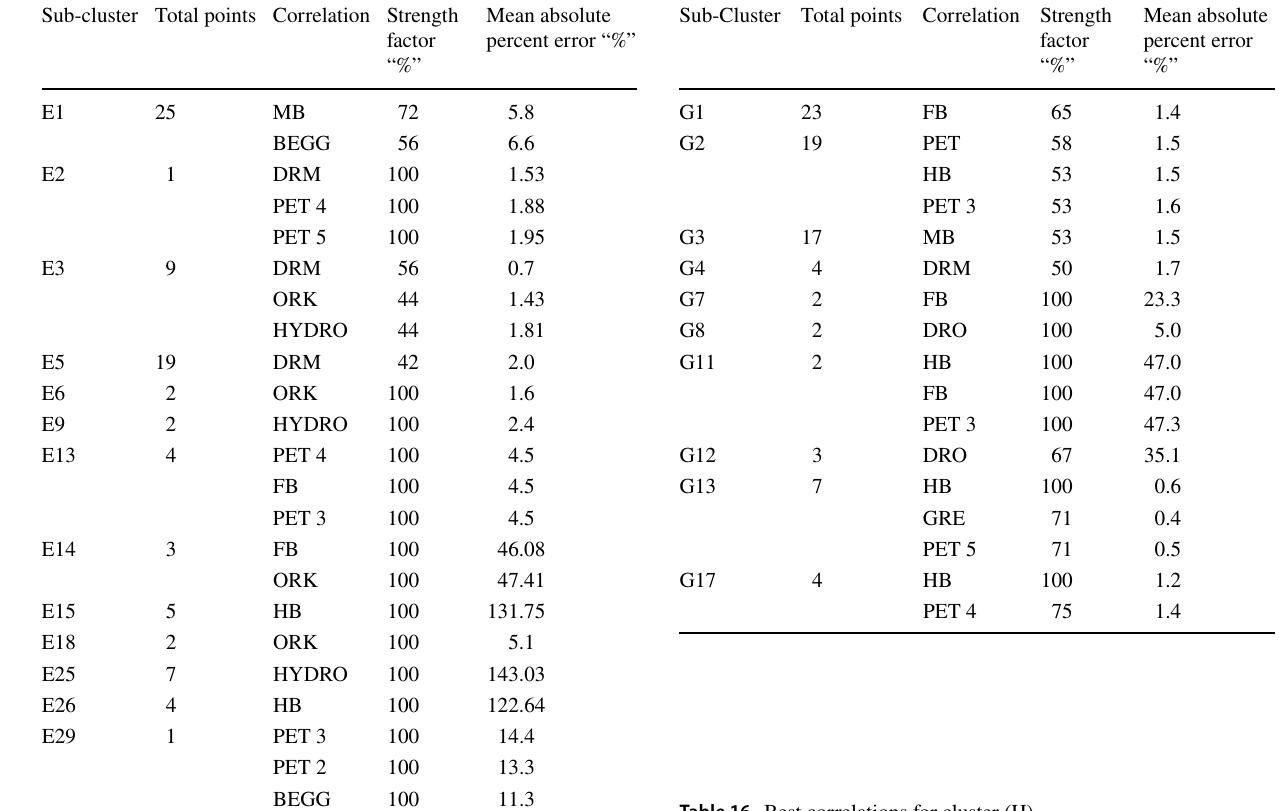
Table 16 Best correlations for cluster